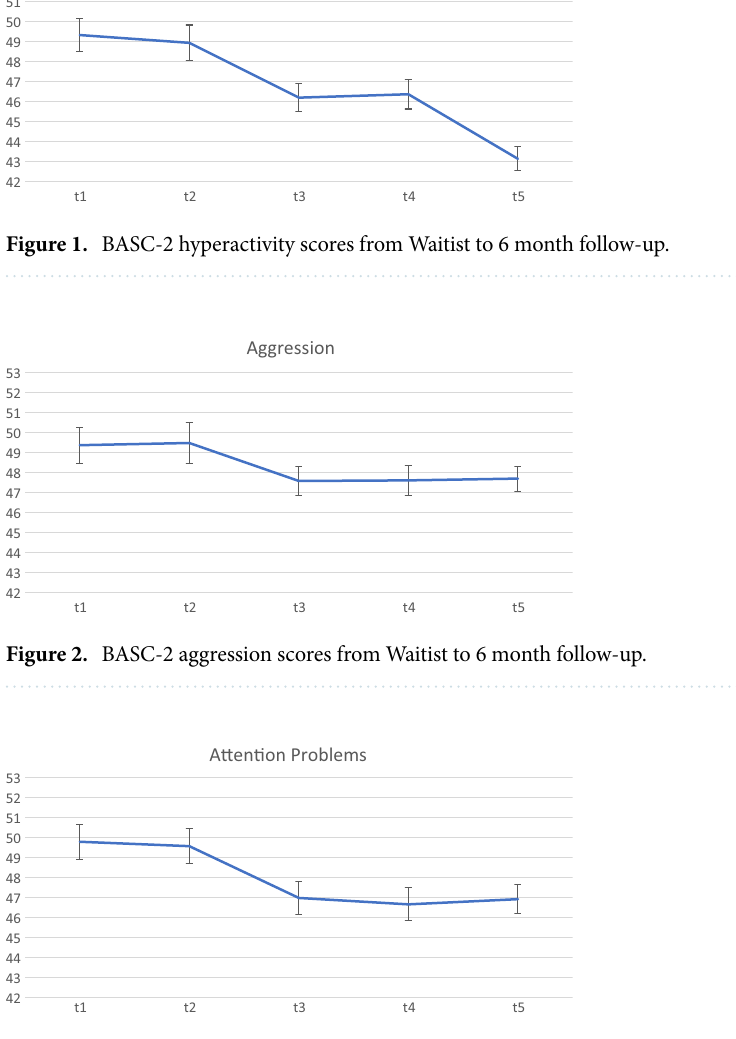
Figure 3. BASC-2 attention Problems scores from Waitist to 6 month